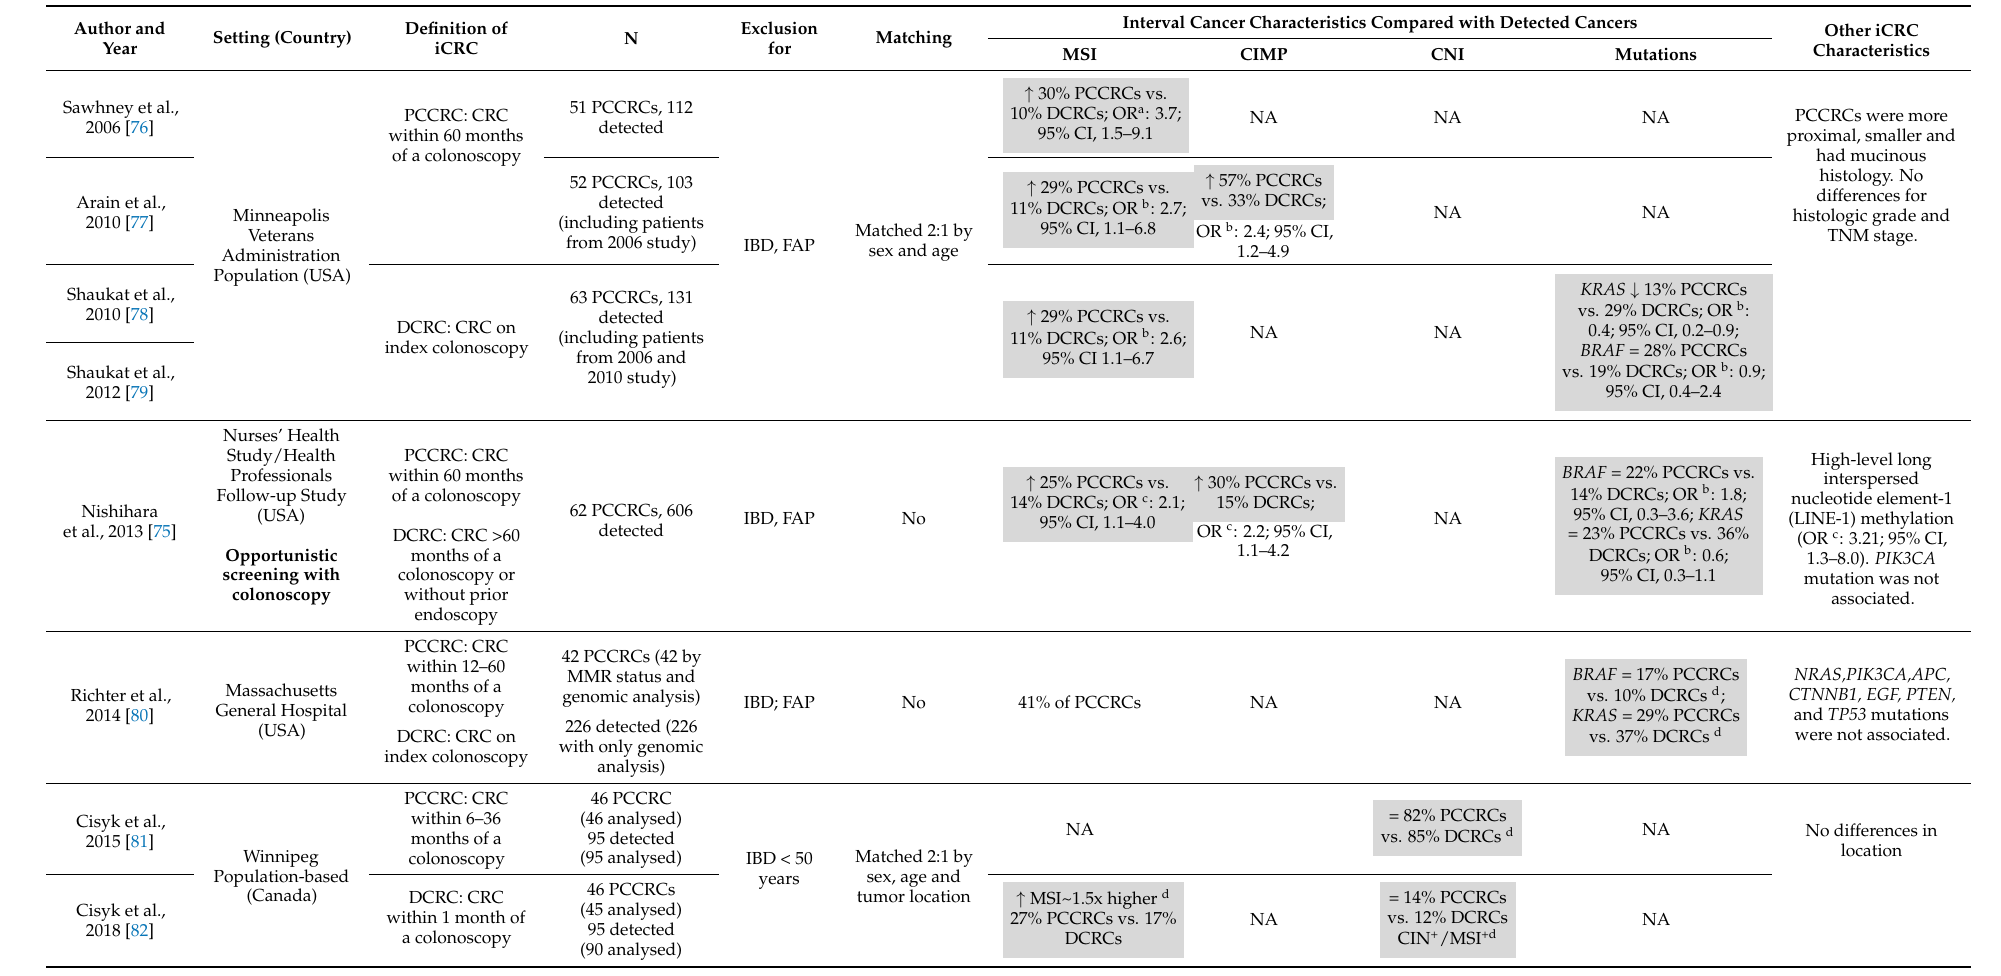
Table 2. Studies that molecularly characterized interval